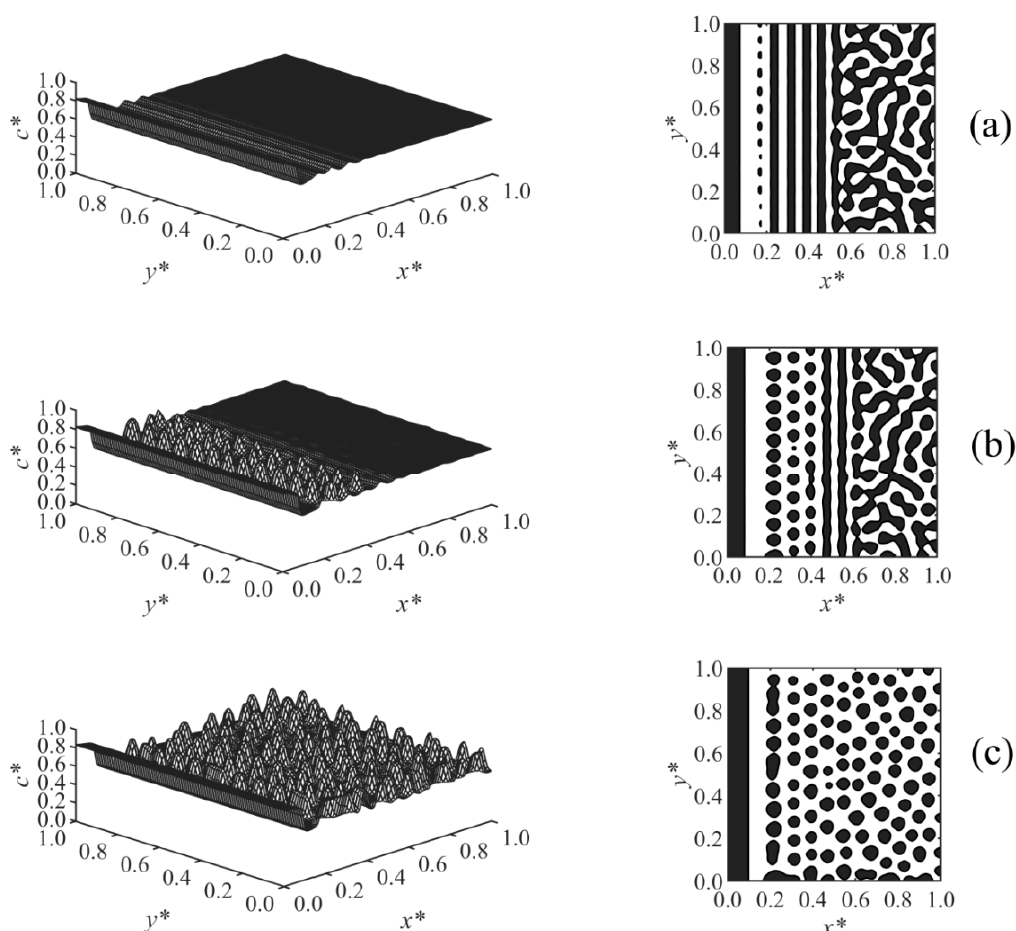
Figure 2. Spatial concentration distributions (first column) and phase-separated morphologies (second column) for Case 1 at the following times: ( a ) t * = 9.825 × 10 − 5 , ( b ) t * = 9.835 × 10 − 5 , and ( c ) t * = 9.85 × 10 − 5 .